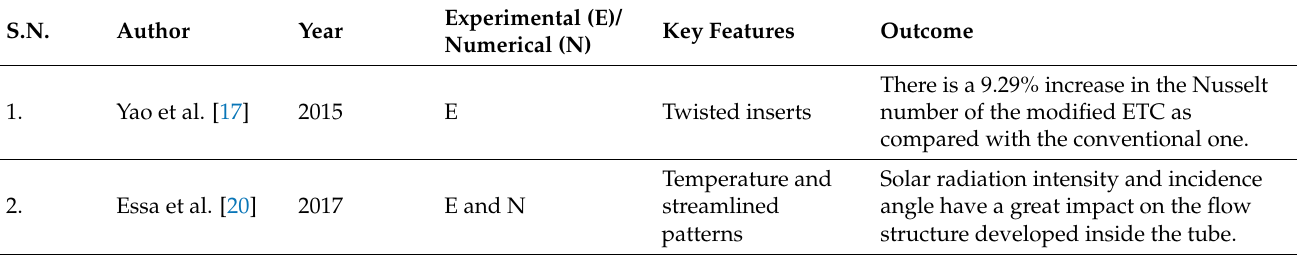
Table 1. Summary of selected investigations on all glass tube ETC-PCM/nanofluid-based